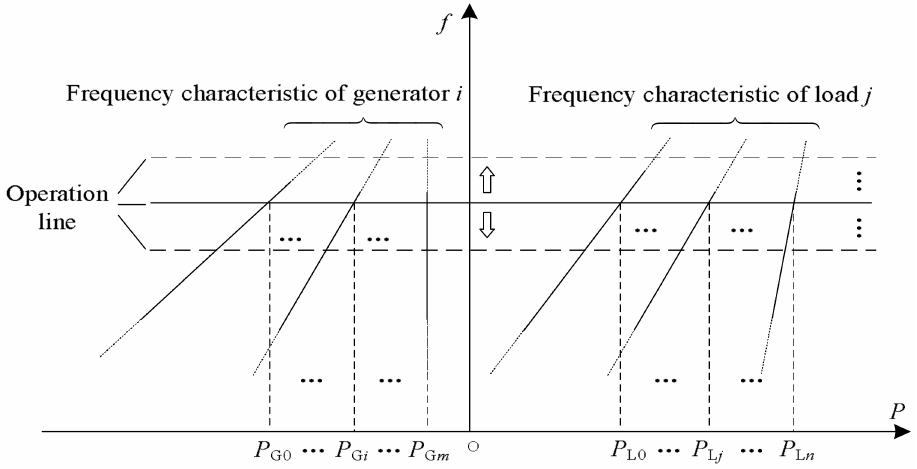
Figure 3. Diagram of S-L analysis